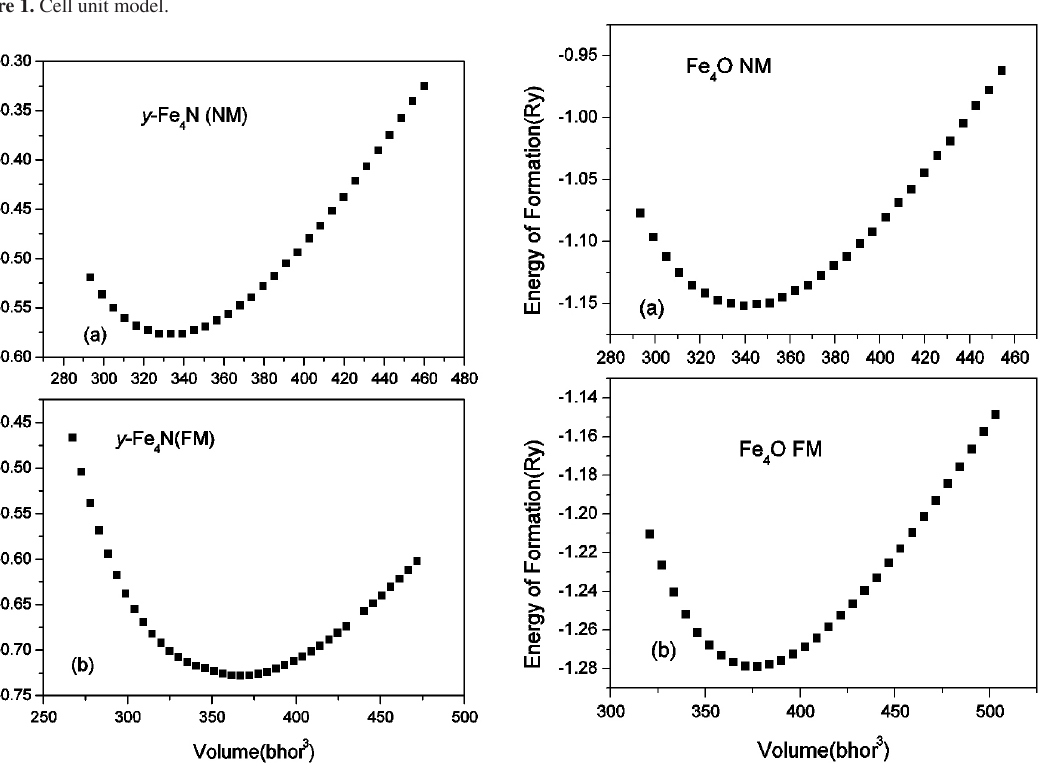
Figure 3. Energy of formation depending on the volume of oxide Fe O in ferromagnetic and non-magnetic 4